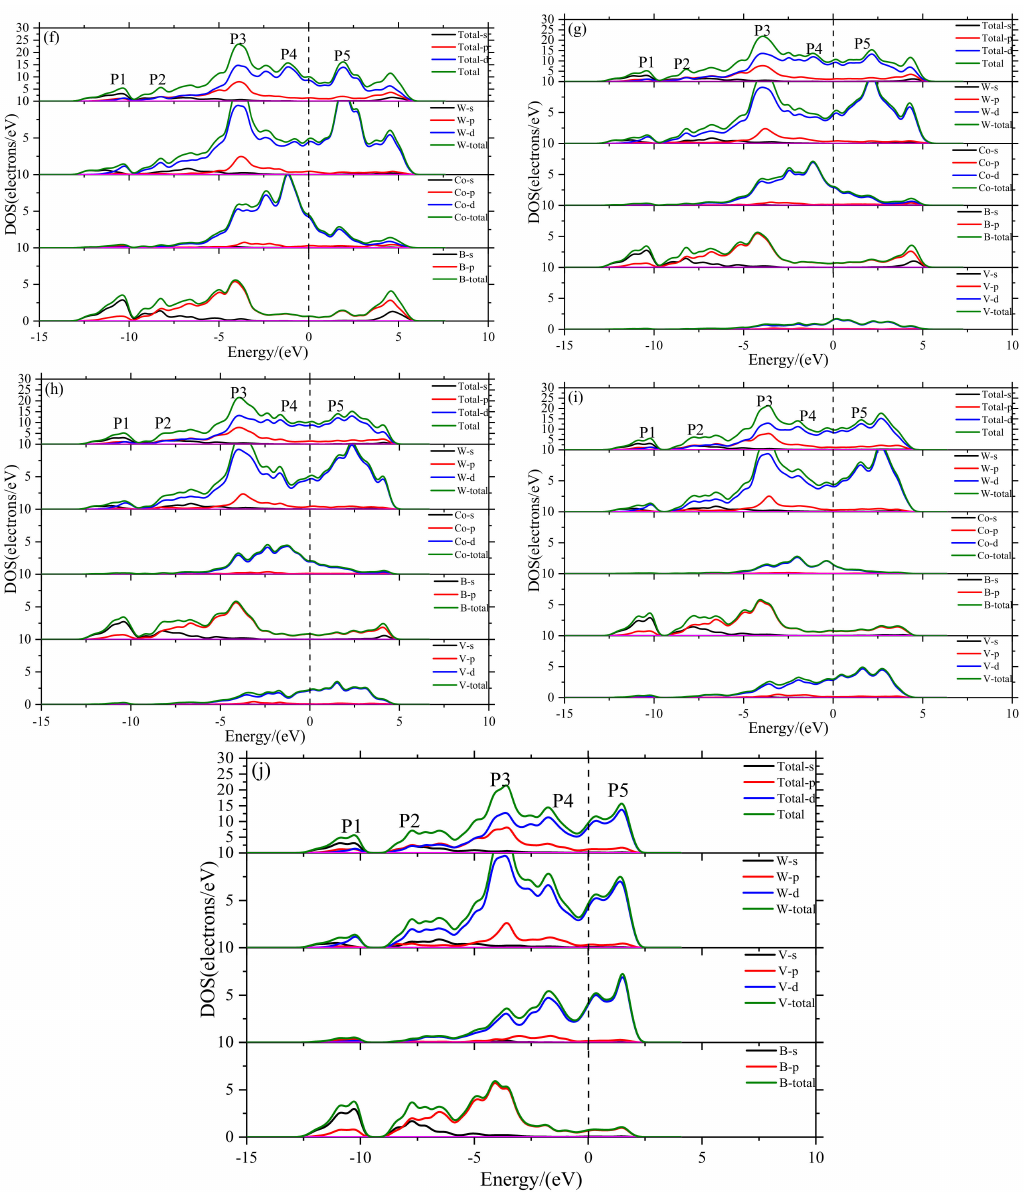
Figure 5. Plots of total and partial density of states of WCoB with different V doping content (( f ) W 8 Co 4 B 8 ; ( g ) W 8 Co 3 VB 8 ; ( h ) W 8 Co 2 V 2 B 8 ; ( i ) W 8 CoV 3 B 8 ; ( j ) W 8 V 4 B 8